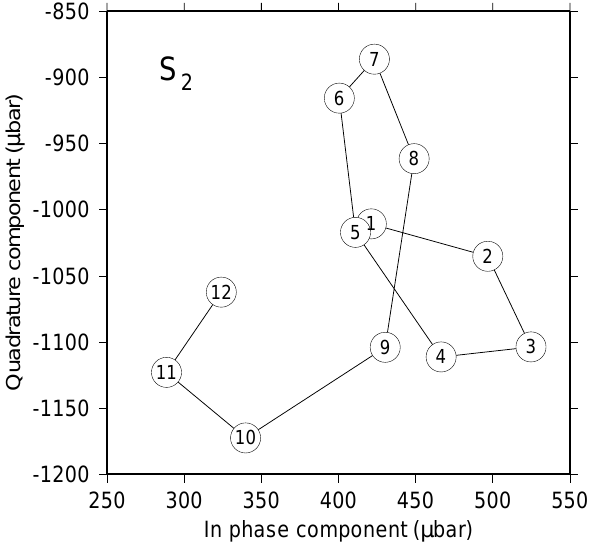
Fig. 11. Monthly estimates of the in-phase (A 2 cos κ 2 ) and quadra- ture (A 2 sin κ 2 ) components of the S 2 (p) tide, averaged over all tropical regions (latitudes ≤ 23 ◦ ). Months are labeled 1–12.